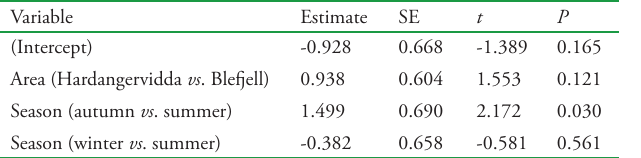
Table 6. Summary of the generalized linear mixed-effects model for predicting the probability of rein- deer groups assessing an observer before fleeing. The response variable is binomially distributed (0=no